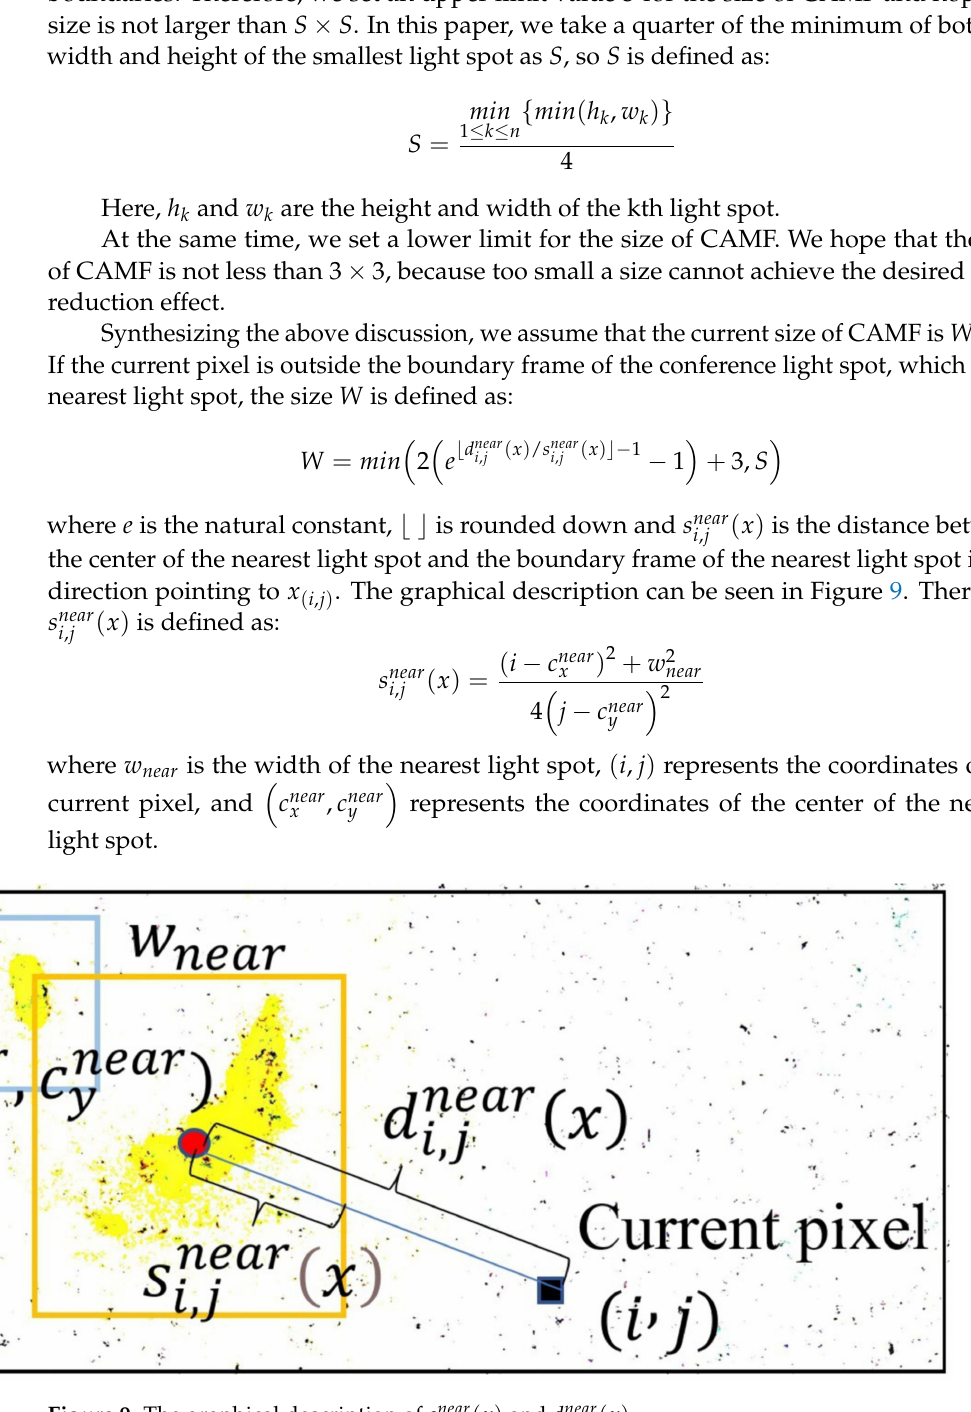
Figure 9. The graphical description of s near